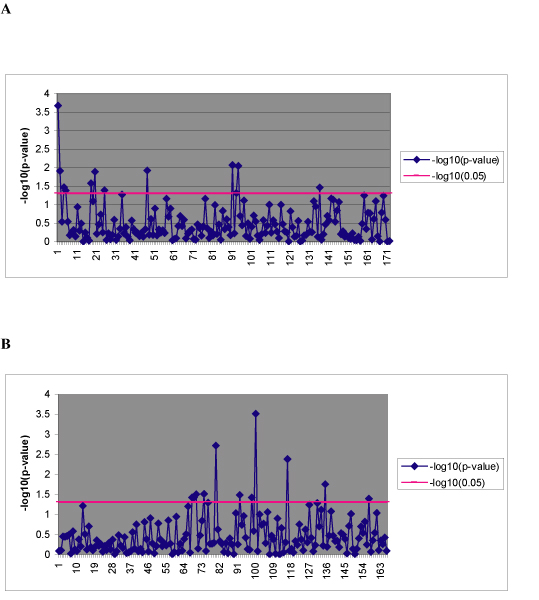
Association results of all markers in chromosome 14 (A) and chromosome 15 (B). The p-values are in the form of -log10(p-value). The solid line indicates the cut-off for 0.05 significance level.